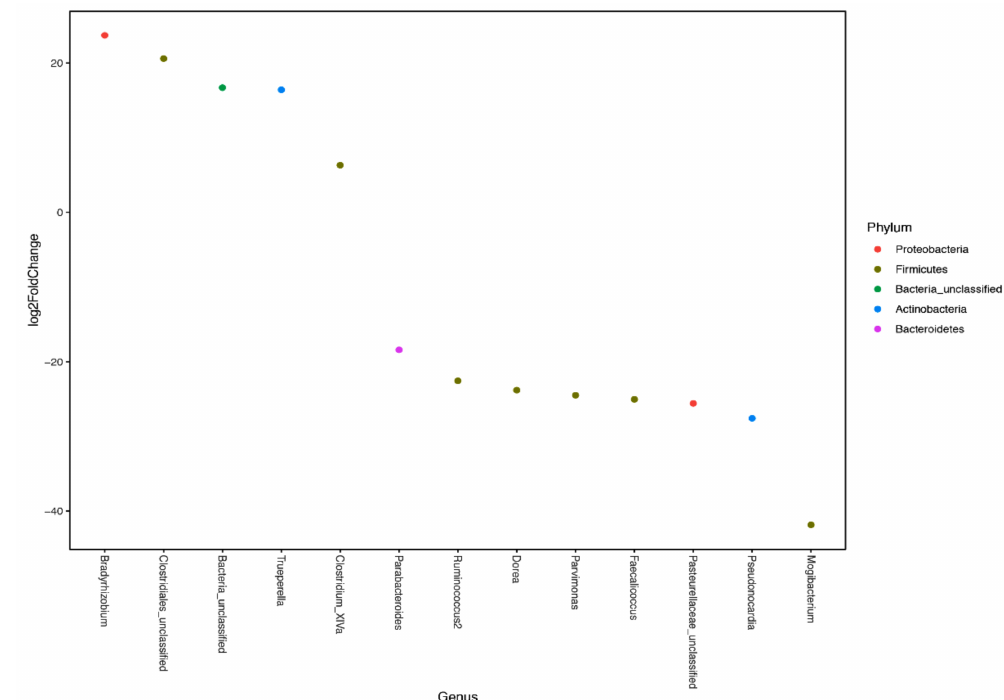
Figure 6. For di ff erential abundance analysis. Phyloseq microbiota data were converted to DESeq2 datasets and analyzed using the Wald test with a parametric fit to test for significance. All plots were generated using the package ‘ggplot2 (cid:48) . To lessen the impacts of rare operational transcriptional units (OTU), the raw OTU counts were agglomerated at the genus level. Log2 fold change in di ff erential abundance at the genus level within phyla was compared between genera present in the ileal mucosa for CR and CD calves, respectively. Color of dots represents the main phyla analyzed and position of dots represent increase or decrease in representation of specific genera due to colostrum feeding. Genera shown are statistically significant at p <